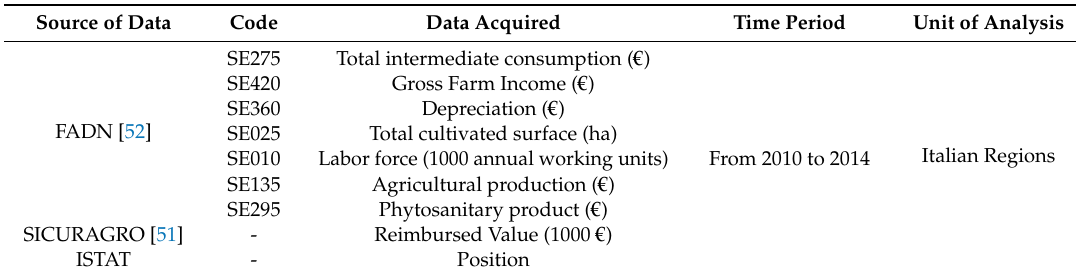
Table 1. Sources of